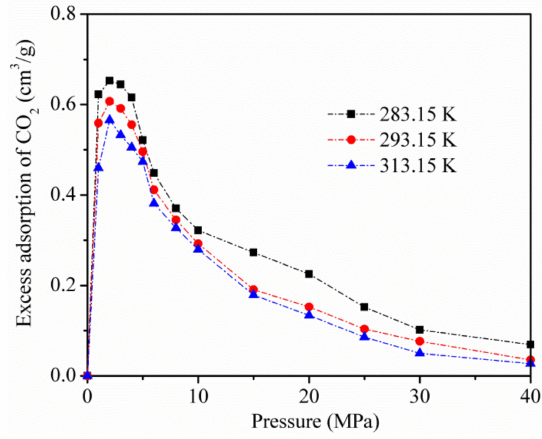
Figure 4. Excess adsorption of CO 2 on kaolinite at temperatures of 283.15, 293.15, and 313.15 K.